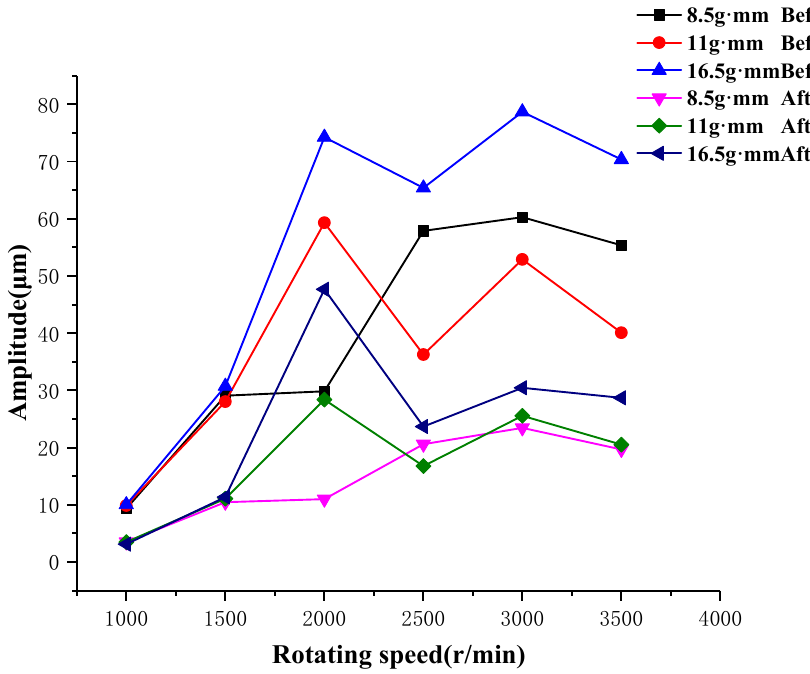
Figure 9. Amplitude before and after balancing without optimized